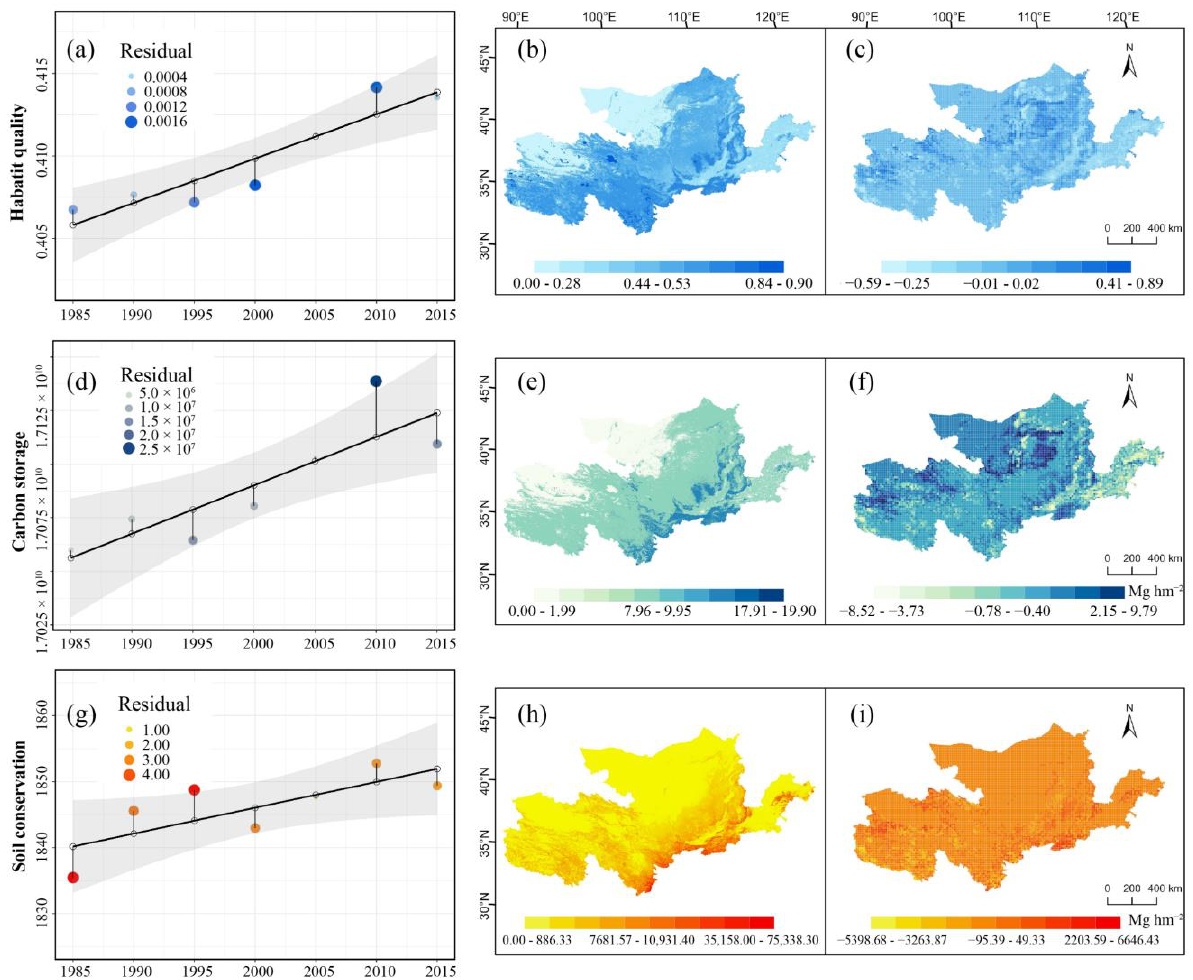
Figure 5. Spatial patterns and trends in ESs changes in YRB from 1985 to 2015 in ( a ) average habitat quality ( d ) total carbon storage, Mg ( g ) average soil conservation, Mg hm −2 ; Black line is the fitting curve of ESs interannual variation, point represents the regional observed values and predicted values for the year with 95% CI in gray. Residual is the absolute value of predicted values minus observed values; ( b , e , h ) pixel-scale habitat quality, carbon storage, and soil-conservation-distribution maps in 2015, respectively; ( c , f , i ) change trends in average habitat quality, carbon storage, and soil conservation by grid from 1990 to 2015, respectively.